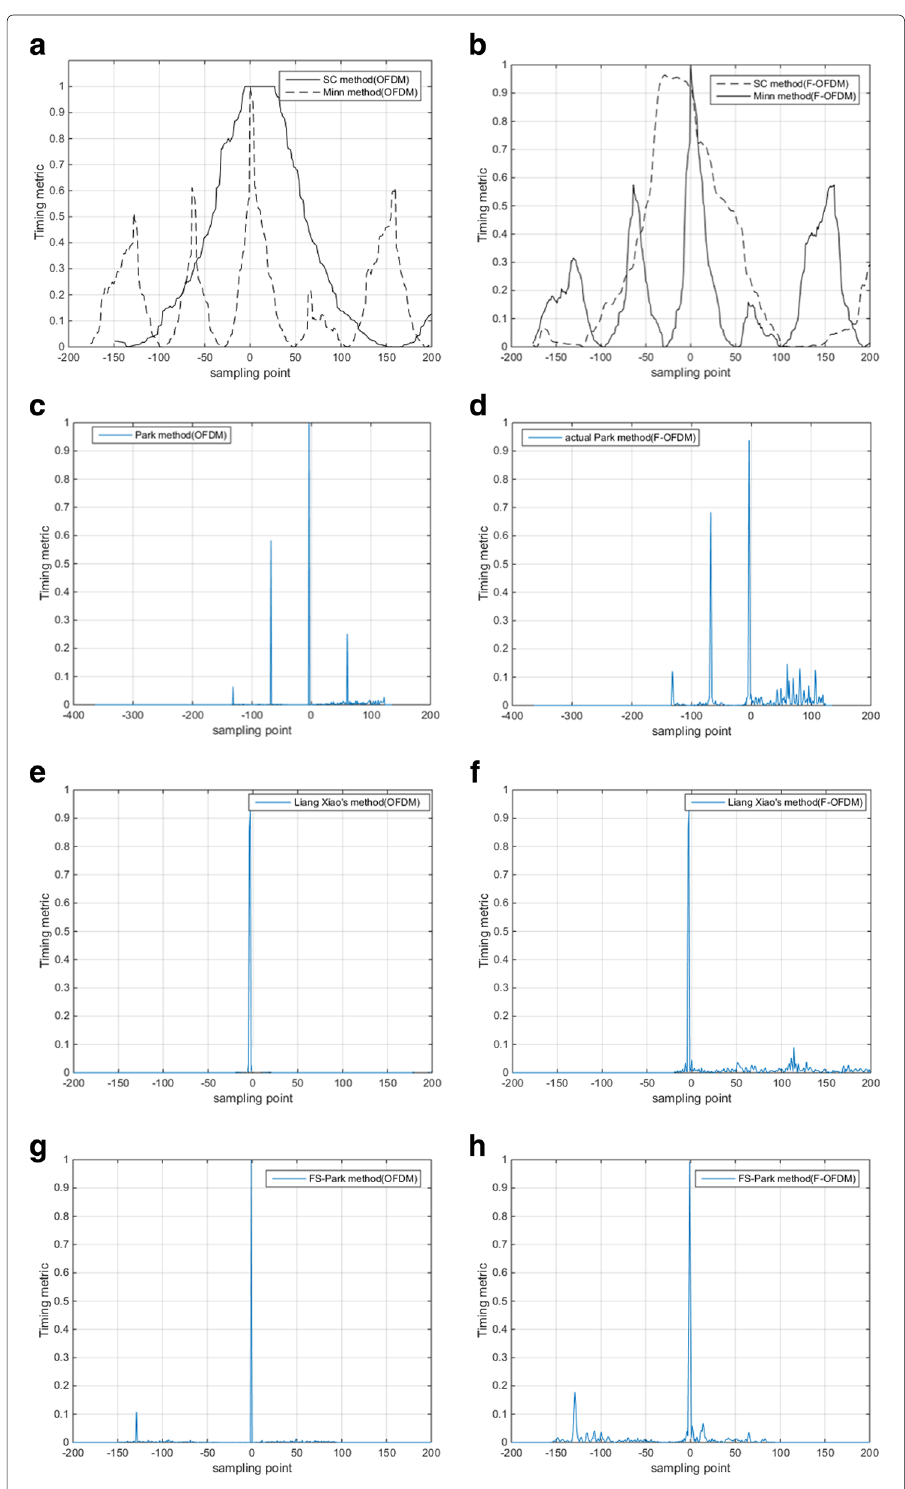
Fig. 9 Comparison of timing metric